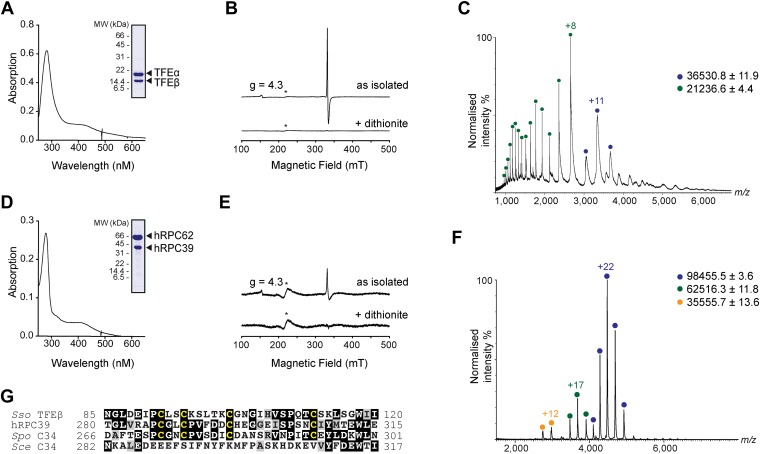
The C-terminal domain of Sso TFEβ harbours a 4Fe-4S cluster that is conserved in human RNAPIII subcomplex hRPC62/39.(A) UV-vis spectrum of TFEα/β-His. (B) Cw-EPR spectra of TFEα/β prepared in the presence of 1 mM DTT with or without the addition of 20 mM Na-dithionite. Besides the main [3Fe-4S]+ cluster signal at g = 2.01, a small amount of spurious high spin Fe3+ at g = 4.3 was also detected. The asterisks denote a background signal. (C) Nano-electrospray ionization (nESI) mass spectrum of TFEα/β-His. Filled circles indicate the different charge state series: TFEα/β-His + Zn ion + 4Fe-4S cluster (blue), TFEα + Zn ion (green). (D) UV-vis spectrum of recombinant human RNAP III subcomplex hRPC62/C39. (E) Cw-EPR spectra of hRPC62/39 prepared in the presence of the reducing agent Na-dithionite. The asterisks denote a background signal. (F) nESI mass spectrum of recombinant human hRPC62/C39. Filled circles indicate the different charge state series: hRPC62/C39 complex + 4Fe-4S cluster (blue), monomeric hRPC62 (green), monomeric hRPC39 (yellow). (G) Sequence alignment of the C-terminal domains of S. solfataricus TFEβ (gene id: 1455187), H. sapiens hRPC39 (gene id: 10621), Schizosaccharomyces pombe C34 (gene id: 2538992), and S. cerevisiae C34 (gene id: 855737). Identical and similar residues are shaded in black and grey, respectively. The four cysteine residues coordinating the FeS cluster are highlighted in yellow.DOI:
http://dx.doi.org/10.7554/eLife.08378.00810.7554/eLife.08378.009Figure 2—source data 1.Theoretical and experimentally calculated masses of proteins and protein complexes.